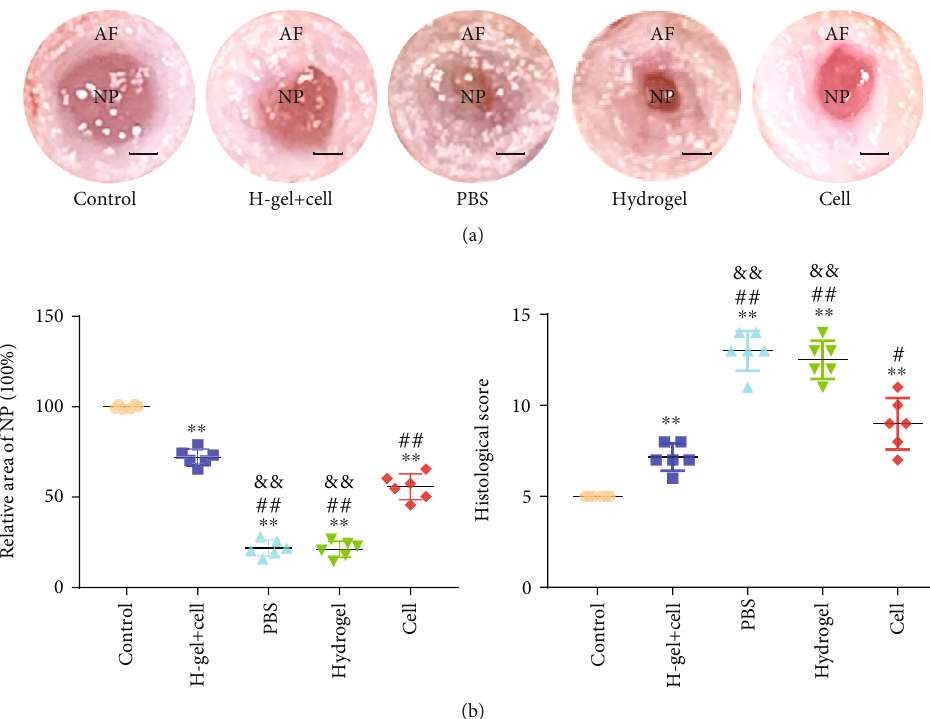
Figure 9: Macroscopic observation and histological score of di ff erent groups. (a) Macroscopic images of di ff erent groups at 8 weeks after injection. (b) The relative area of nucleus pulposus at 8 weeks after injection. (c) Histological scores obtained at 8 weeks after injection. The H-gel+cell group is the hydrogel+cell group. Data represent mean ± SD ; the error bars represent the standard deviation of measurements for 6 separate samples ( n = 6 ); ∗ p < 0 : 05 , ∗∗ p < 0 : 01 compared with control group; # p < 0 : 05 , ## p < 0 : 01 compared with hydrogel+cell group; & p < 0 : 05 , && p < 0 : 01 compared with cell group. Scale bar = 1 mm